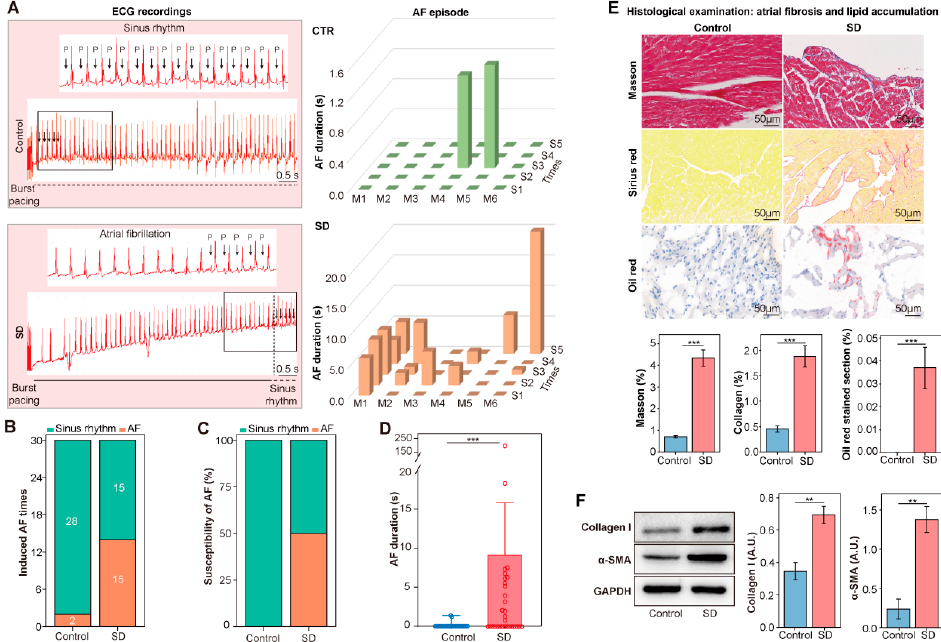
Figure 1. Enhanced AF inducibility, atrial lipid accumulation, and fibrosis in SD mice. ( A ) Representative image of surface ECG recordings during burst pacing in control and SD group. AF inducibility ( B ), AF susceptibility ( C ), and AF duration ( D ) in the control ( n = 6) and SD group ( n = 6). Chi-square test. ( E ) Representative Masson trichrome, Sirius Red, and Oil red O staining for fibrosis disarray, collagen deposition, and lipid droplets in the atrium. ( F ) Representative Western blot and the expression levels of collagen I and α -SMA in mouse atria of the two groups. Data are presented as the mean ± SEM. **, p < 0.01;***, p < 0.001; n = 3 for each group, Student’s t-test.